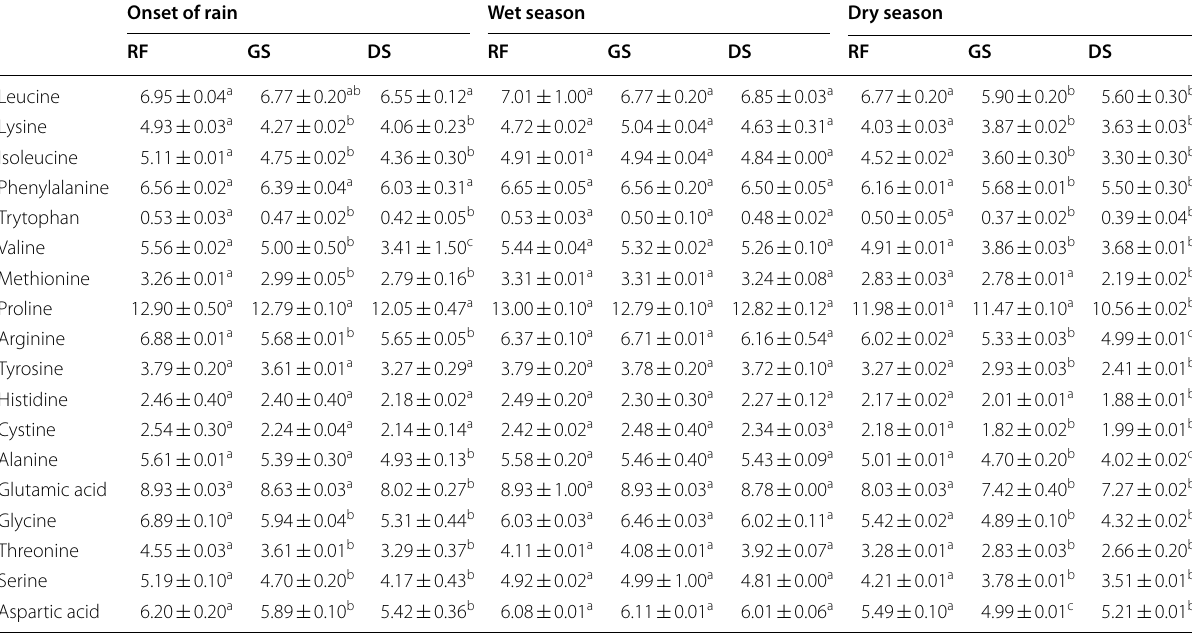
RF rainforest; GS Guinea savannah; DS derived savannah abc Means ( standard deviation) of amino acid components in the same row for each of the seasonal periods having similar superscripts are not significantly different ± at p < 0.05